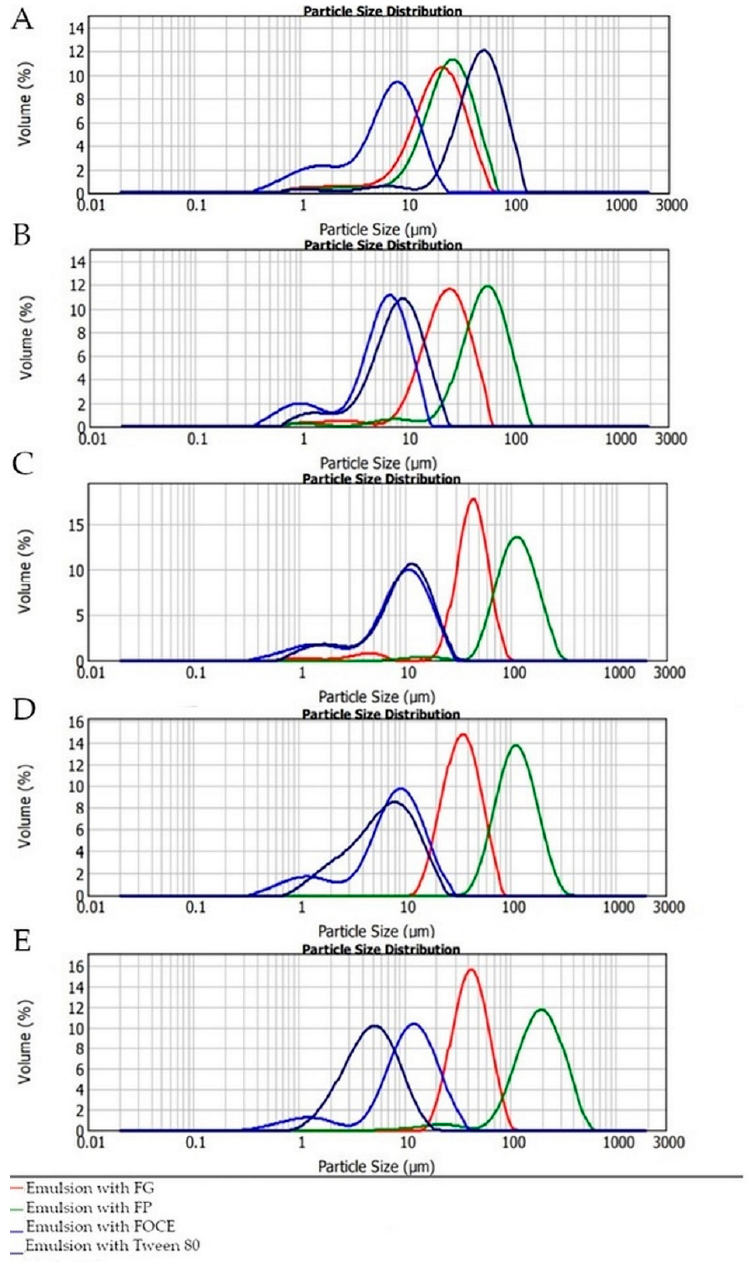
Figure 5. Particle size distribution of emulsions prepared with various content of FO with FOCE, FG, FP and Tween 80. FOCE—flaxseed oil cake extract; FG—flaxseed gum solution; FP—flaxseed protein solution; ( A – E ): emulsions prepared with 10%, 20%, 30%, 40% and 50% oil phase, respectively. Values are means ± standard deviation of triplicate determinations. Means with different letters in the same column are significantly different at p < 0.05.